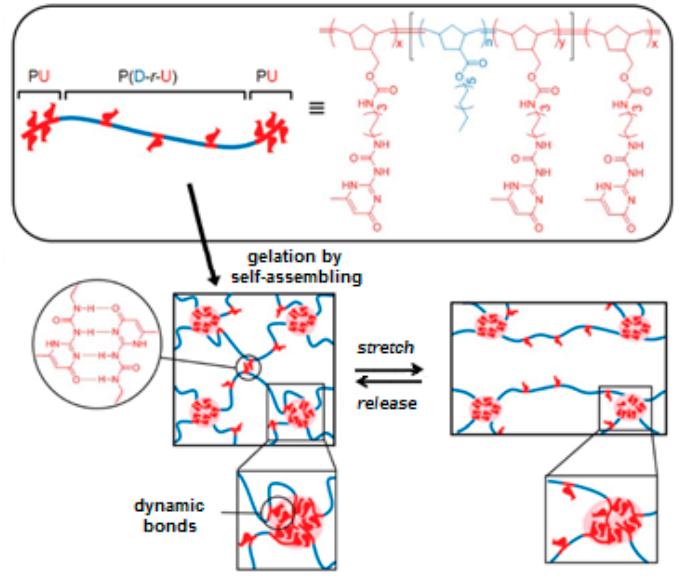
Figure 6. Microphases with different crosslinking densities formed by triblock copolymers of PU (dimer of 2-ureido-4[1H]-pyrimidinone (Upy)-functionalized norbornene) and P(D- r -U) (random copolymer of UPy-functionalized norbornene and dodecany norbornene): hard domains with dense crosslinks of PU; soft domains with dynamic crosslinks of P(D- r -U). From [169], with the permission of John Wiley and Sons.